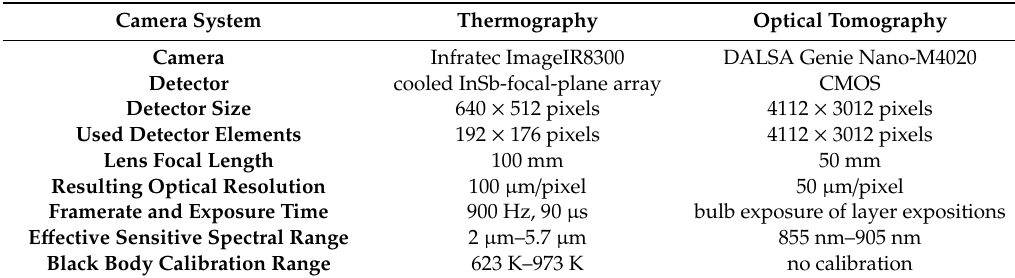
Table 2. Technical data of the used